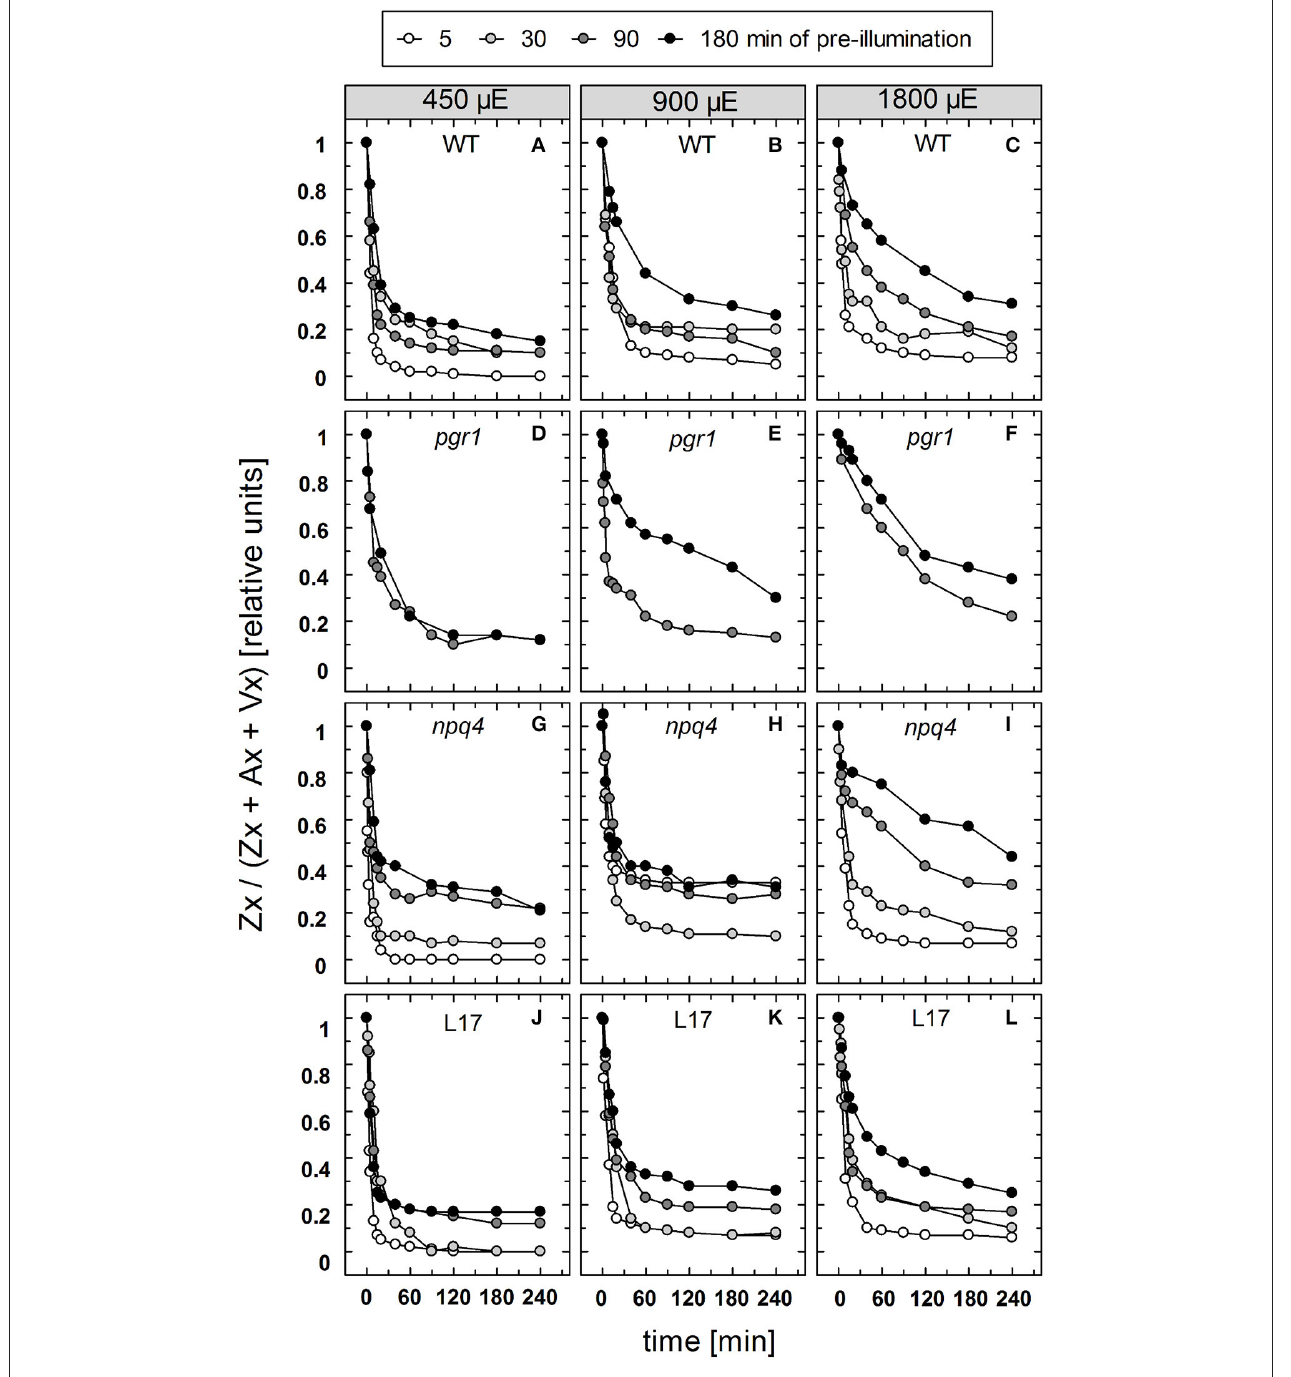
FIGURE 7 | Zx epoxidation. The reconversion of Zx to Vx after pre-illumination at three different actinic light intensities (450, 900, and 1,800 µ E of white light) for 5, 30, 90, and 180min was determined for WT (A–C) , pgr1 (D–F) , npq4 (G–I), and L17 (J–L) plants. During the whole experiment, detached leaves were placed on water in temperature-controlled cuvette (20 ◦ C). At indicated time, leaves were rapidly frozen in liquid N 2 and the pigment composition was determined by HPLC analyses. The Zx content in % of the total VAZ-pool size ( = sum of Vx, Ax and Zx) is shown. Data represent mean values of 3–4 independent measurements. For clarity, error bars, which ranged from 1 to 5% in all cases, are not